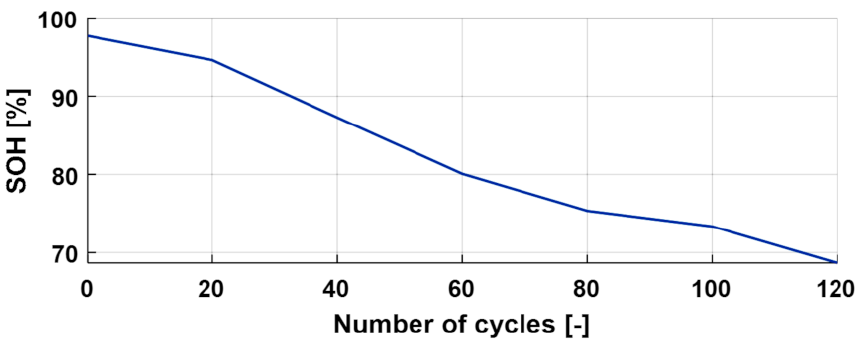
Figure 18. SOH of cylindrical Sanyo NCR 18650 GA lithium-ion cell across the aging cycles.